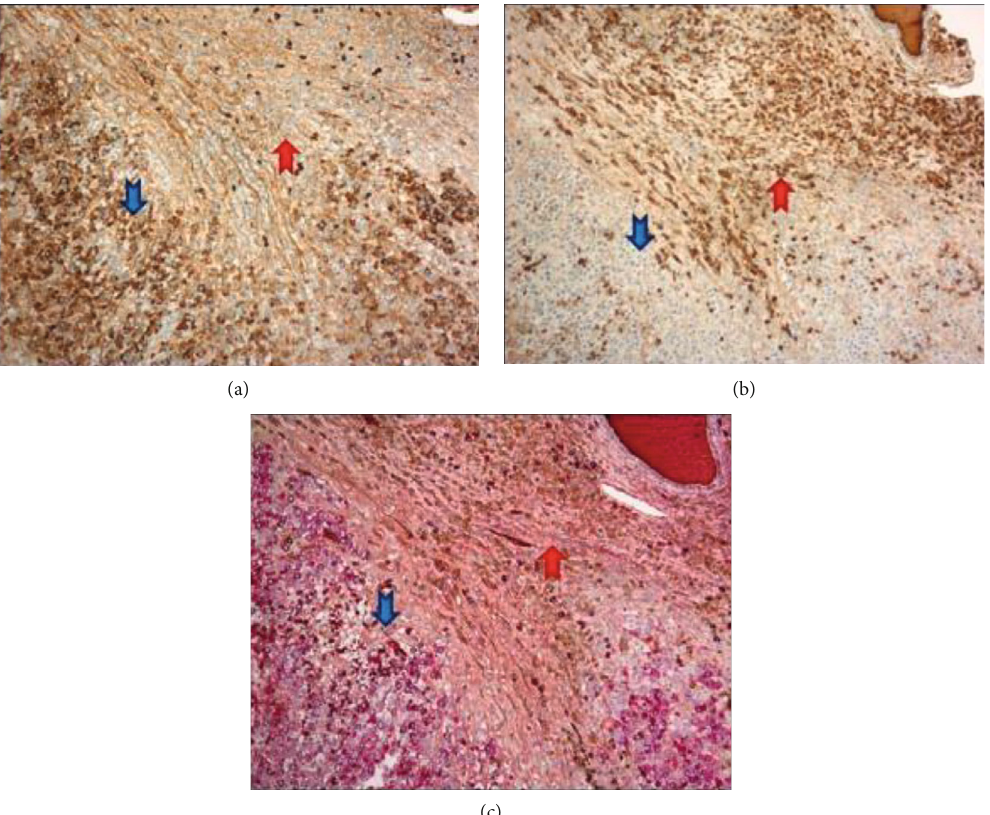
Figure 3: (a) Immunohistochemical stain for lambda, positive in the PBL (blue arrow) and predominately negative in the mature plasma cell component (red arrow) (100x). (b) Immunohistochemical stain for kappa, positive in the mature plasma cell component (red arrow) and essentially negative in the PBL cells (blue arrow) (100x). (c) Dual immunohistochemical stain for kappa and lambda showing lambda light chain restriction in the PBL cells (blue arrow) and kappa restriction in the mature plasma cell component (red arrow)